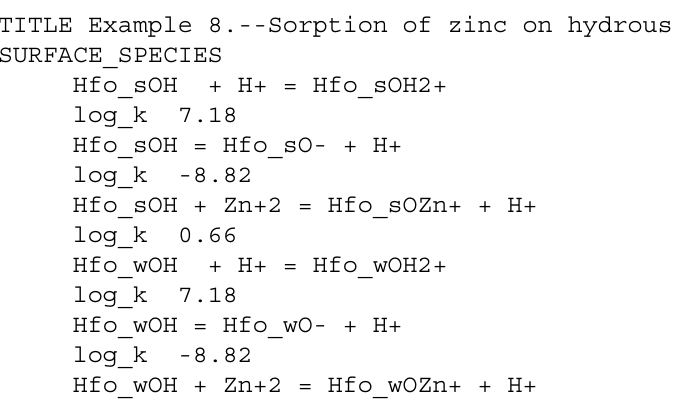
Table 27. Input file for example